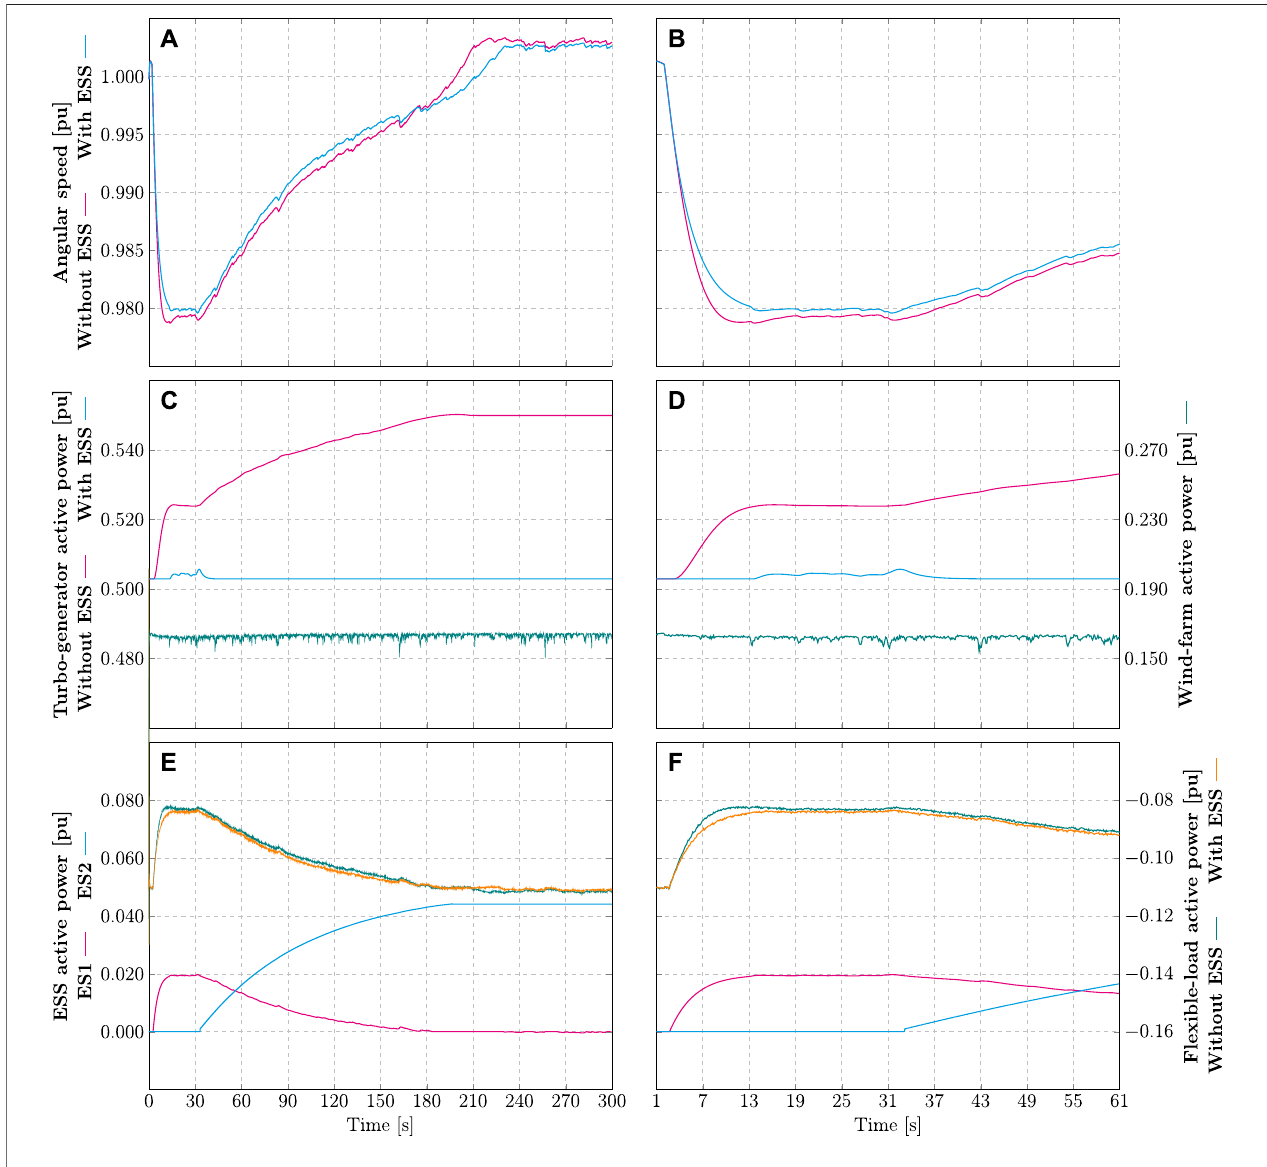
FIGURE 9| Case study behavior during a load increase of3MW with and without the proposed ESS: normalized angular speed (A) during the wholetransient and (B) detail of the fi rst minute; turbo-generator and wind farm active power in pu (C) during the whole transient and (D) detail of the fi rst minute; active power of the ES devices responsible for primary control (ES1) and secondary control (ES2) (E) during the whole transient and (F) detail of the fi rst minute.